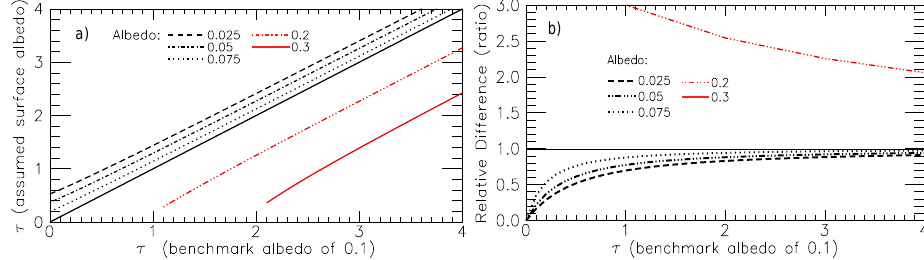
Fig. 8. (a) Absolute and (b) relative difference (ratio) between the result of a retrieval of τ and the given values derived by creating a cirrus with optical thicknesses between 0 and 4, a fixed surface albedo of 0.1 and the same retrieval assuming a surface albedo of 0.025, 0.05, 0.075, 0.2 and 0.3.